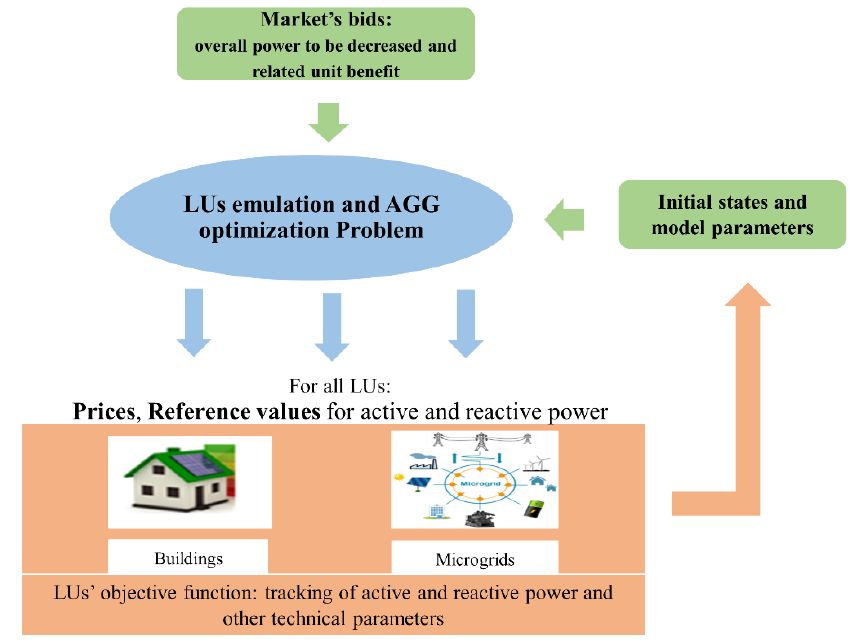
Figure 1. The proposed decision architecture of the Aggregator (AGG)–Local Users (LUs)